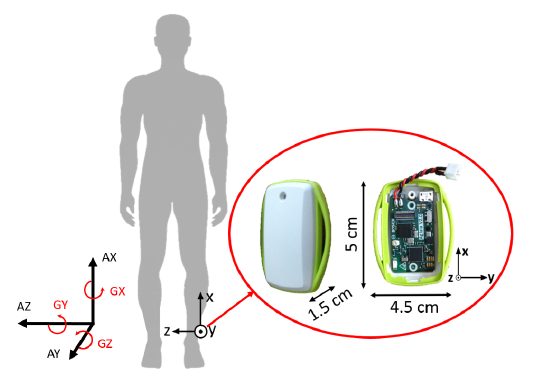
Figure 3. Sensor placement, size and orientation. Three-dimensional acceleration (AX, AY, AZ) and three-dimensional gyroscope (GX, GY, GZ).